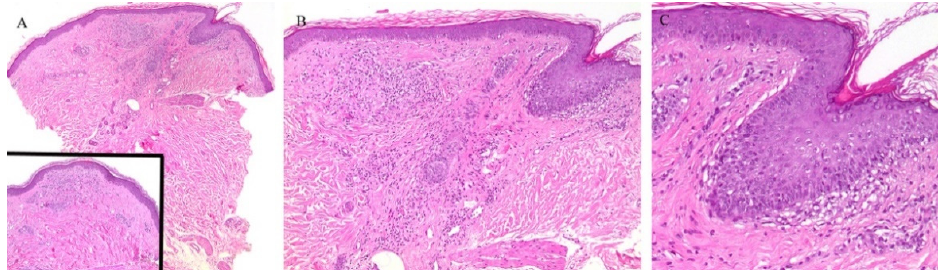
Figure 3. ( A – C ) Lichen nitidus with follicular involvement (the inset in Figure A shows a deeper section of the same case with more characteristic lichen nitidus